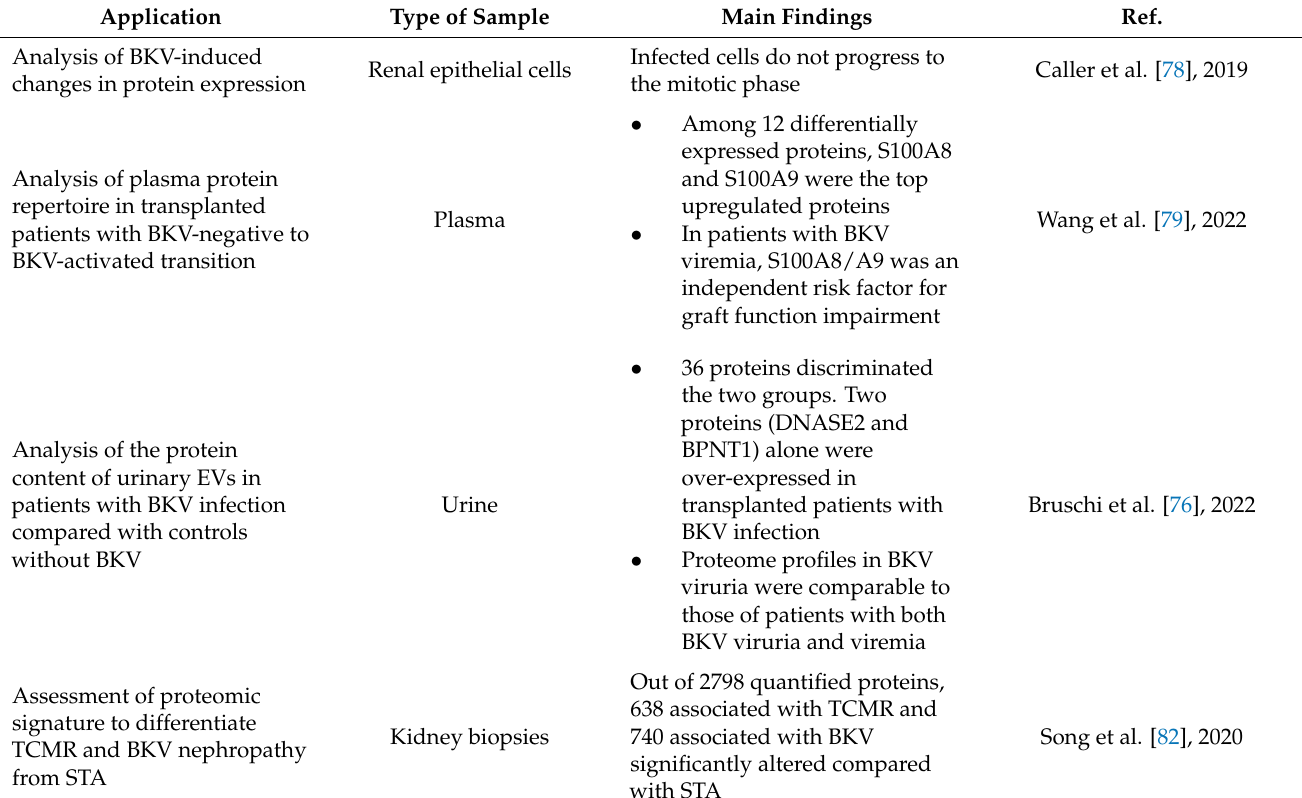
Table 6. Recent proteomic studies on BKV infection in the setting of kidney